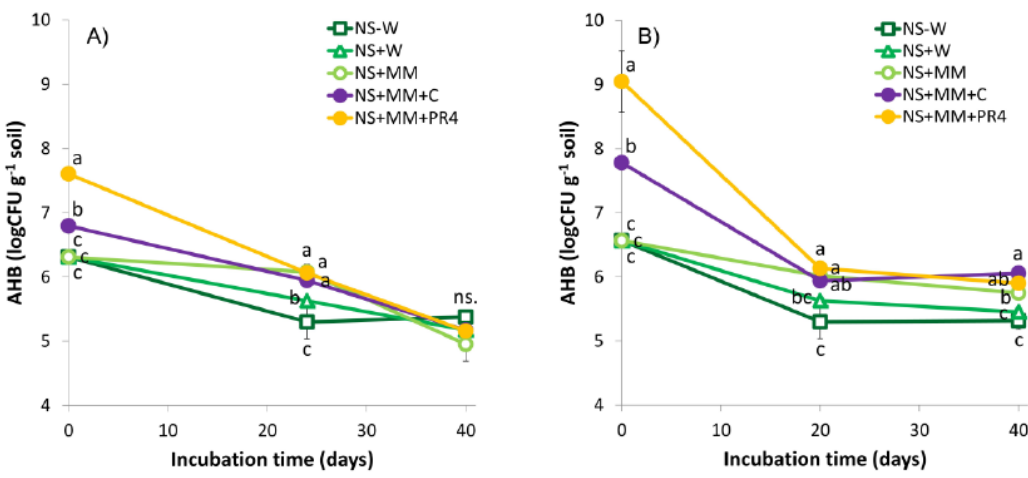
Figure 5. Changes in the numbers of aerobic heterotrophic bacteria (AHB) in soil microcosms when applying a ( A ) smaller and a ( B ) larger size of inoculum for bioaugmentation. For comparison, the CFUs of the non-treated, moistured and biostimulated samples are also displayed. Different letters in the same remediation time indicate statistical differences among treatments ( n = 3, p ≤ 0.05).